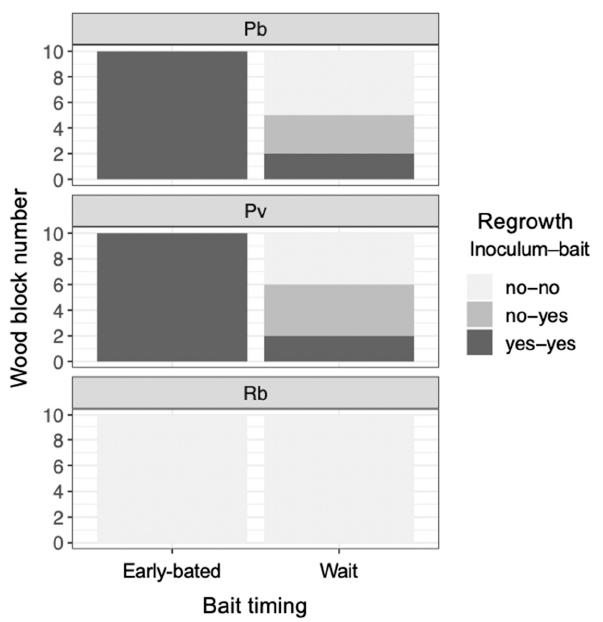
Figure 4. The frequency of wood blocks (inoculum and bait) with/without hyphal regrowth 7 d after the blocks had been transferred to new soil dishes, depending on the timing of bait added.